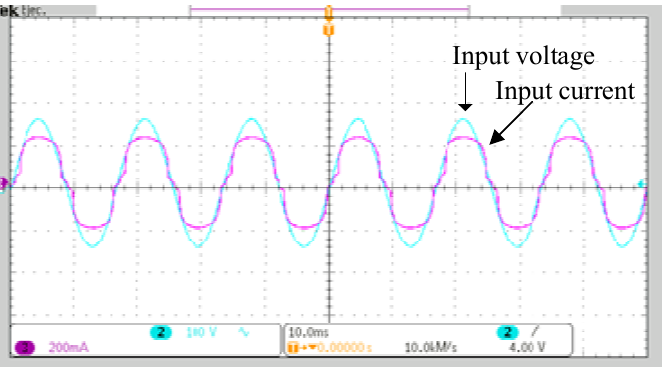
Figure 20. Waveforms: input current (purple, 200 mA/div), input voltage (blue, 100 V/div).